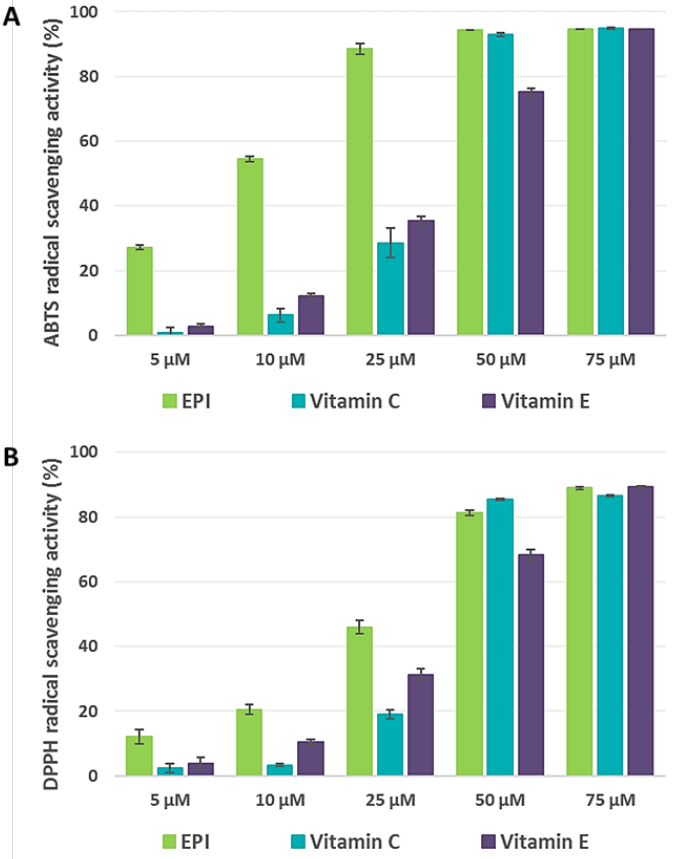
Figure 8. Anti-oxidative activities of EPI expressed as ABTS ( A ) and DPPH ( B ) free radical scavenging activity comparing to vitamins C and E. Results are expressed as mean ± SD, ( n = 3).